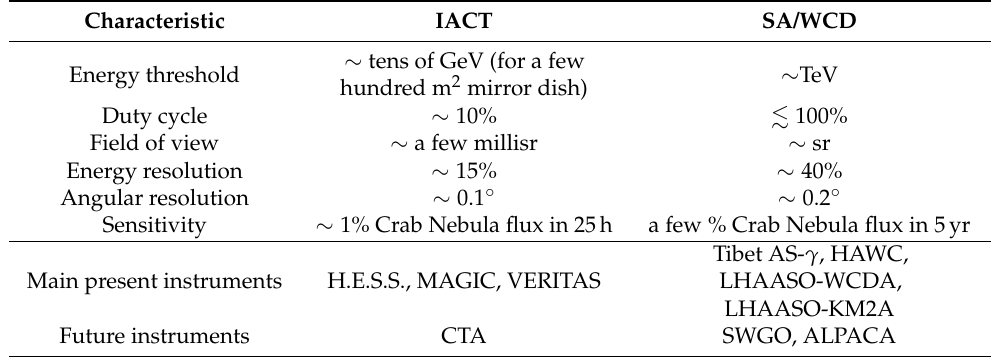
Table 1. Comparison of the typical performance parameters of IACT and SA/WCD instruments. Due to the energy dependence of the performance parameters, the energy resolution, angular resolution and sensitivity are given for the best sensitivity range of IACT or SA/WCD instruments (i.e., about an order of magnitude higher than their corresponding energy thresholds). The values for individual instruments of a given type can vary by a factor of a few, depending on the details of the hardware implementation and analysis methods. Characteristic